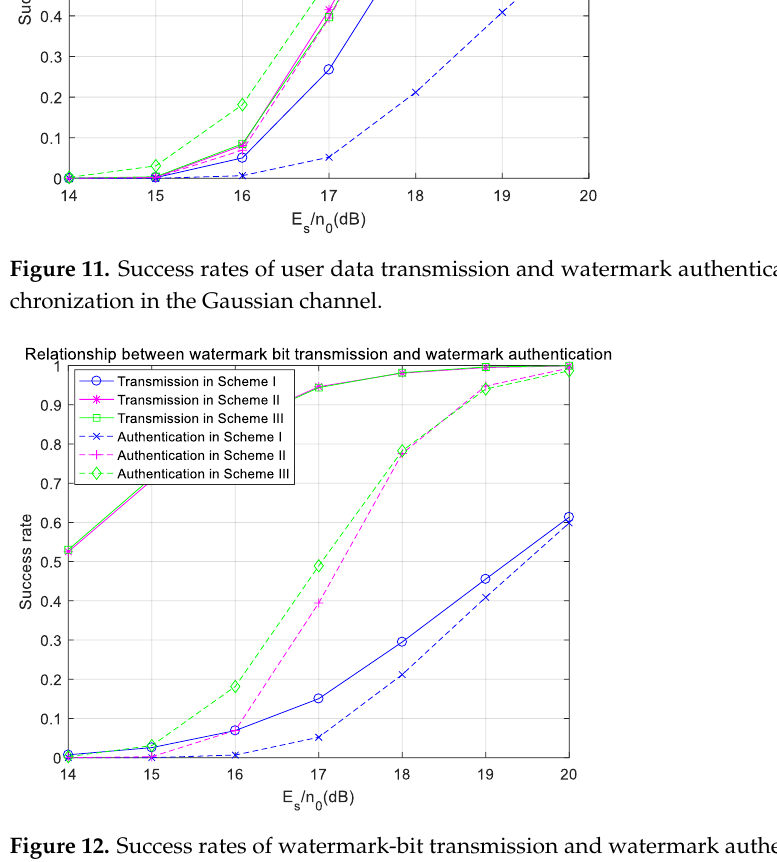
Figure 13. Symbol error rate of user data with a frequency offset in the Gaussian channel. The transmission bit error rates of watermark bits are plotted, and the results are shown in Figure 14. Figure 14 shows the bit error rates of watermark source bits in three schemes with a frequency offset, and also shows the bit error rate of watermark source